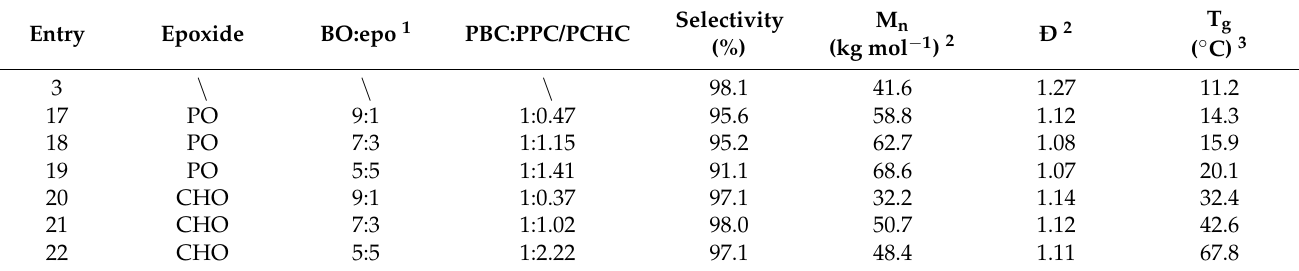
Table 2. Terpolymerization of CO 2 , BO, and other epoxides.